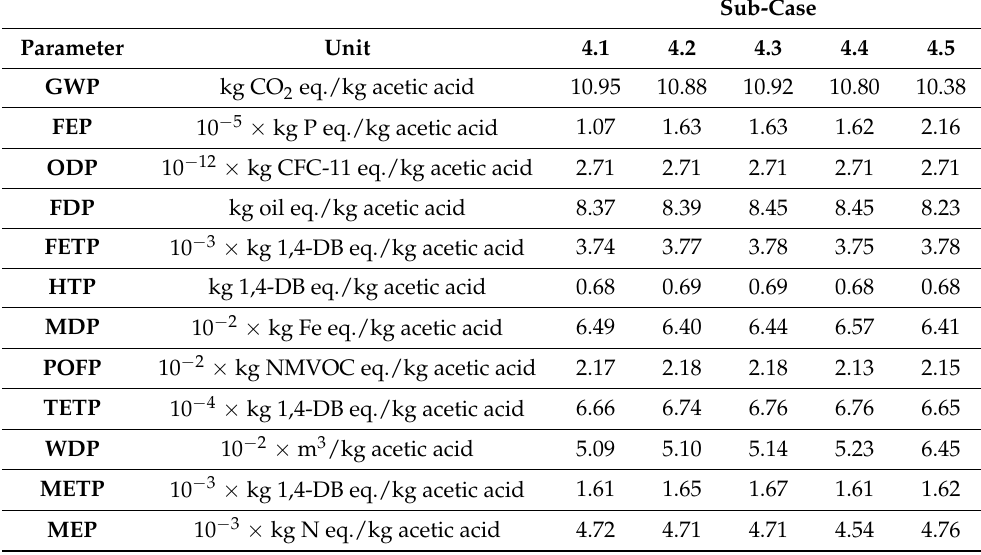
Table 9. LCA results, according to ReCiPe, for the sub-cases correspondent to case